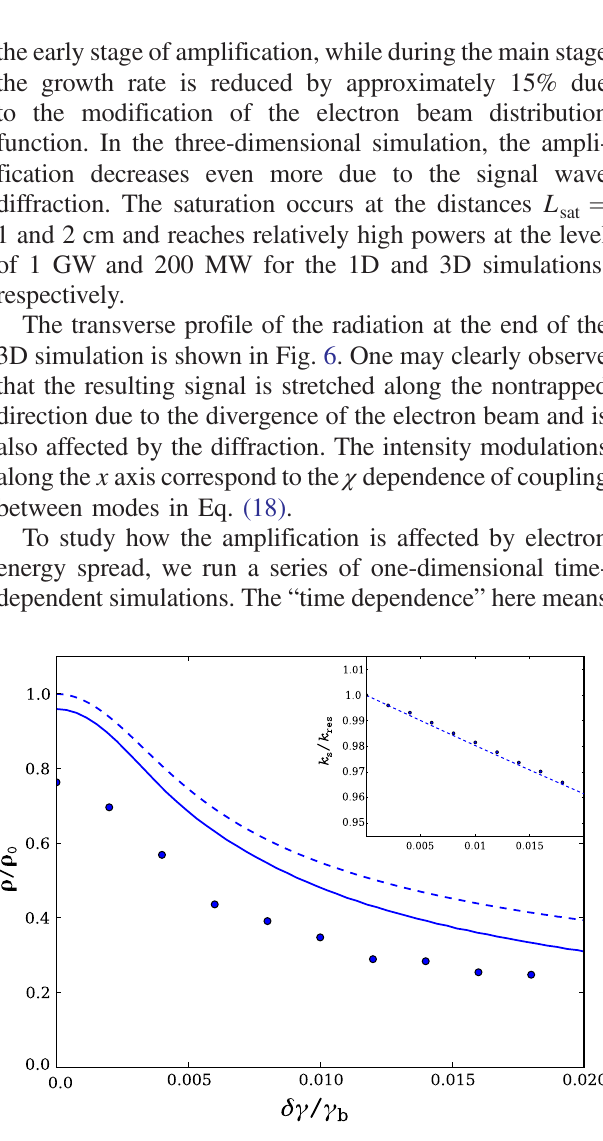
FIG. 6. Steady-state simulations. The intensity profile of the x rays at the end of the interaction in three-dimensional simulation. The color scale is in W = cm 2 .